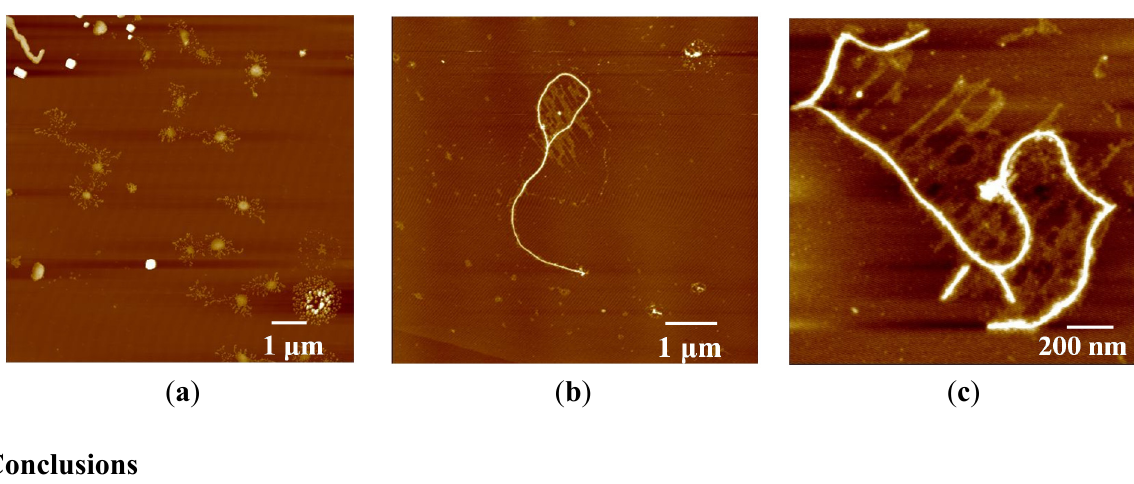
Figure 4. TM-AFM height images of renaturated (1 → 3)(1 → 2)- β - D -Glucan. Images were obtained by depositing the glucan from the (1 → 3)(1 → 2)- β - D -Glucan neutralized